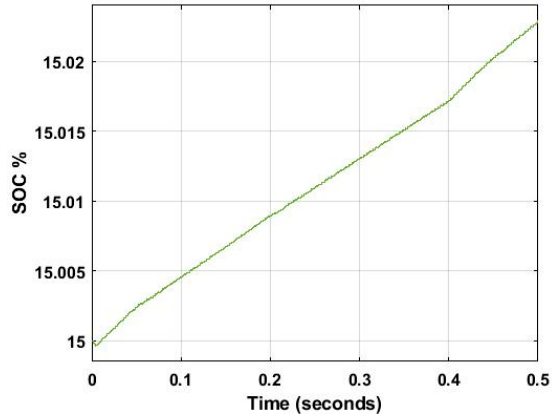
Figure 14. SOC of EV